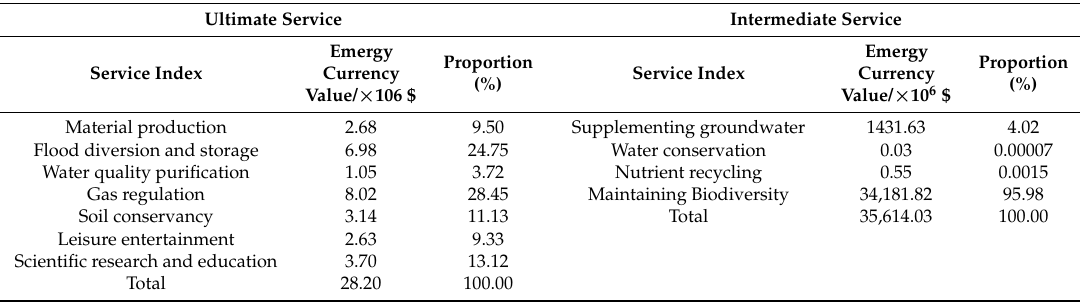
Table 3. Proportion of service value of the Liaohe estuarine wetland